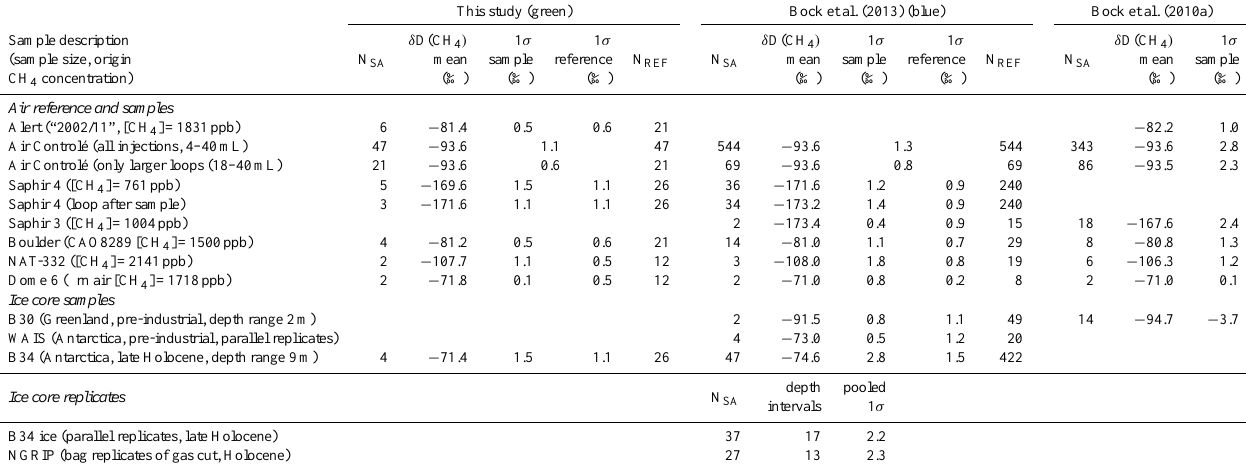
Table 3. Results obtained with the new δ D(CH 4 ) system (green boxes in Fig. 1) in comparison to our previous set-ups (Table 1). Mean values are given in column 3; columns 4 and 5 show standard deviations (1 σ ) of samples and Air Controlé reference air measurements, respectively. Air Controlé measurements are used to calibrate the samples to the international VSMOW scale. Air Controlé has been cross-referenced with respect to Alert (see text). The value given for Alert in the column for 2010 is given by C. Veidt (personal communication, 2014). “N” represents the number of measurements used: subscripts “SA” and “REF” in columns 2 and 6 denote sample and reference (i.e. Air Controlé), respectively. Columns 7–11 are arranged in the same pattern for the data with only basic GC separation after pre&postPT (Bock et al., 2013) (red and blue boxes in Fig. 1). Columns 12–14 show values obtained with the previous set-up presented in Bock et al. (2010a). Ice sample results are not corrected for any firn diffusion process. Gas ages of the ice samples are estimated as follows: B30 – 670aBP, B34 – 1400 to 1530aBP, and WAIS – 410aBP. The WAIS samples are from core WDC05A, tube 184, depth range: 172.74–173.03m. NGRIP gas samples date from between 870 and 9000aBP.